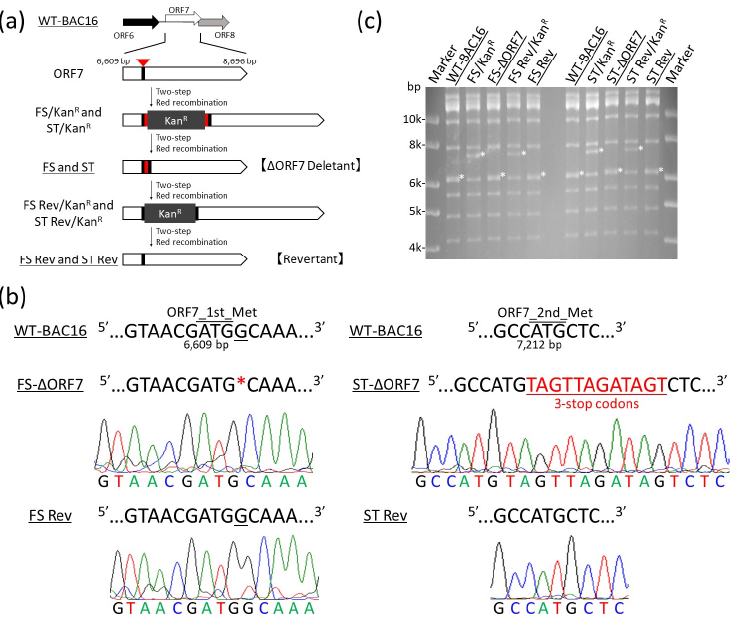
Figure 1. Construction of the frameshift-induced ORF7 and the stop codon-induced ORF7 KSHV BAC16 and their revertants. ( a ) Schematic illustration of the KSHV genome, including the ORF7 coding region. Two different types of ORF7-KO mutations (i.e., a frameshift using a one-base deletion and an insertion of three stop codons) were generated in the ORF7 coding region (nt6609–nt8696; accession number: GQ994935) of wild-type (WT)-KSHV BAC16 clones. The frameshift and insertion mutants were designated FS- ∆ ORF7-BAC16 and ST- ∆ ORF7-BAC16, respectively. Additionally, revertant clones, FS Rev-BAC16 and ST Rev-BAC16, were generated from FS- ∆ ORF7-BAC16 and ST- ∆ ORF7-BAC16, respectively, by replacement of the mutation site with the original DNA sequence. ( b ) The neighboring DNA sequence of the mutation sites in FS- ∆ ORF7-BAC16, ST- ∆ ORF7-BAC16, and their revertant BAC16 clones. ( c ) An image of the gel from agarose gel electrophoresis of the recombinant KSHV BAC16 digested with BglII enzyme. The asterisks indicate insertion or deletion of a kanamycin-resistance cassette in each BAC clone. Original images of the blotting are shown in Supplementary Figure